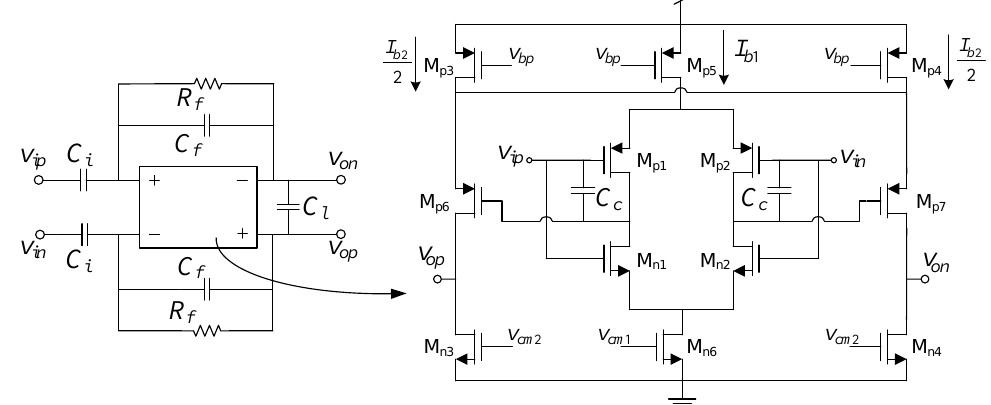
Figure 9. Feedforward compensated capacitive feedback network LNA transistor-level implementation.